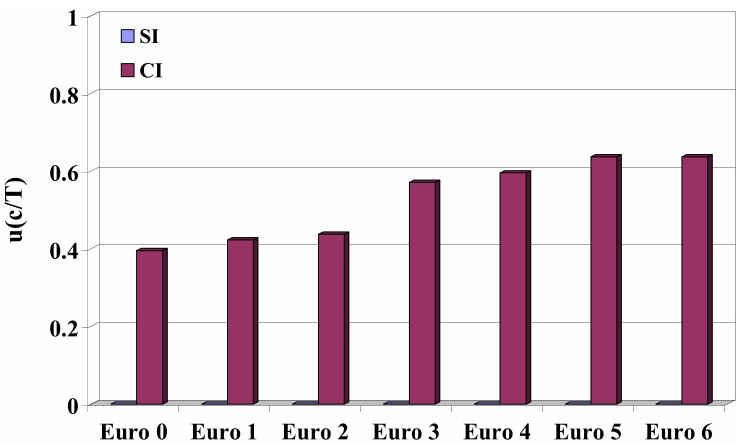
Figure 20. Share of additional particulate matter emission in total emission—u(c/T), from passenger cars of pollutant emission categories Euro 0–Euro 6, during warm-up of spark-ignition engines—SI and compression-ignition engines—CI, under model vehicle traffic conditions.